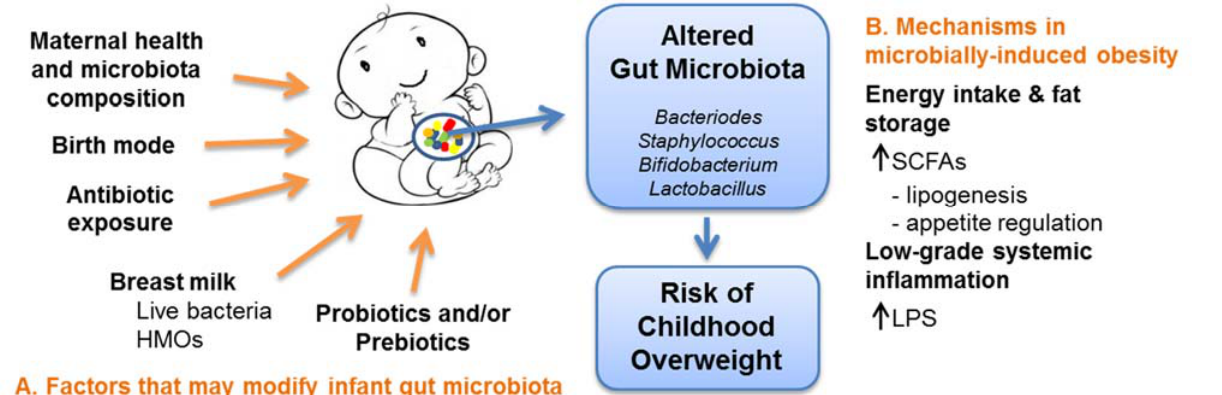
Figure 1. Pre and postnatal exposures demonstrated to modify the infant gut microbiota ( A ) and hypothesized to impact childhood obesity risk through microbial induced mechanisms ( B